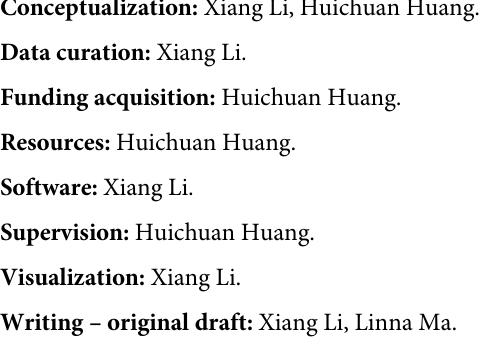
S2 Table. The extracted information from the . txt format file by the function getMotif- FromMEME . S3 Table. The extracted information from the .txt format file by the funxtion importMeme from R package memes with parameters “combined_sites = TRUE”. S1 Fig. Sequence logs of a single motif. S2 Fig. Sequence logs of all